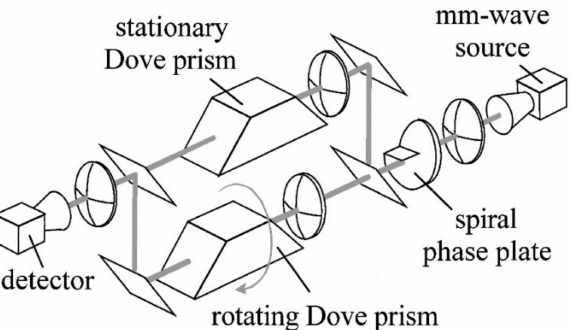
Figure 1. Interferometer for the observation of the rotational Doppler shift. Adapted with permission from Ref.